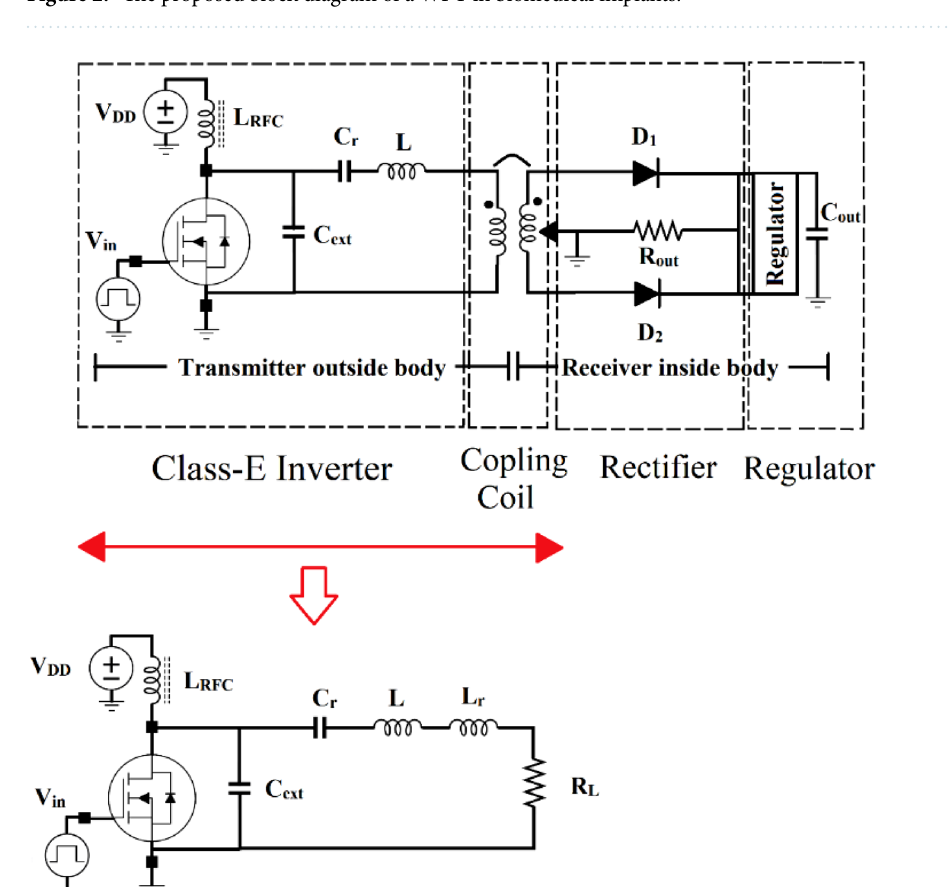
Figure 3. The presented circuit of a WPT is used in biomedical